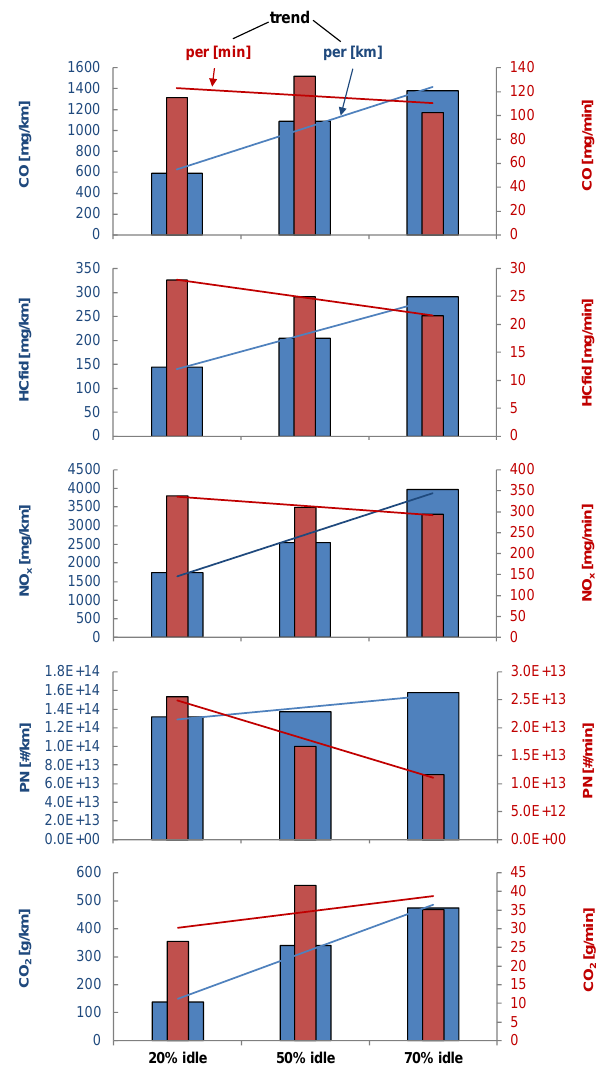
Fig. 15. Emissions of the older Diesel vehicle in the stop&go cycle de- pending on the share of idling; representations as distance-, and time-